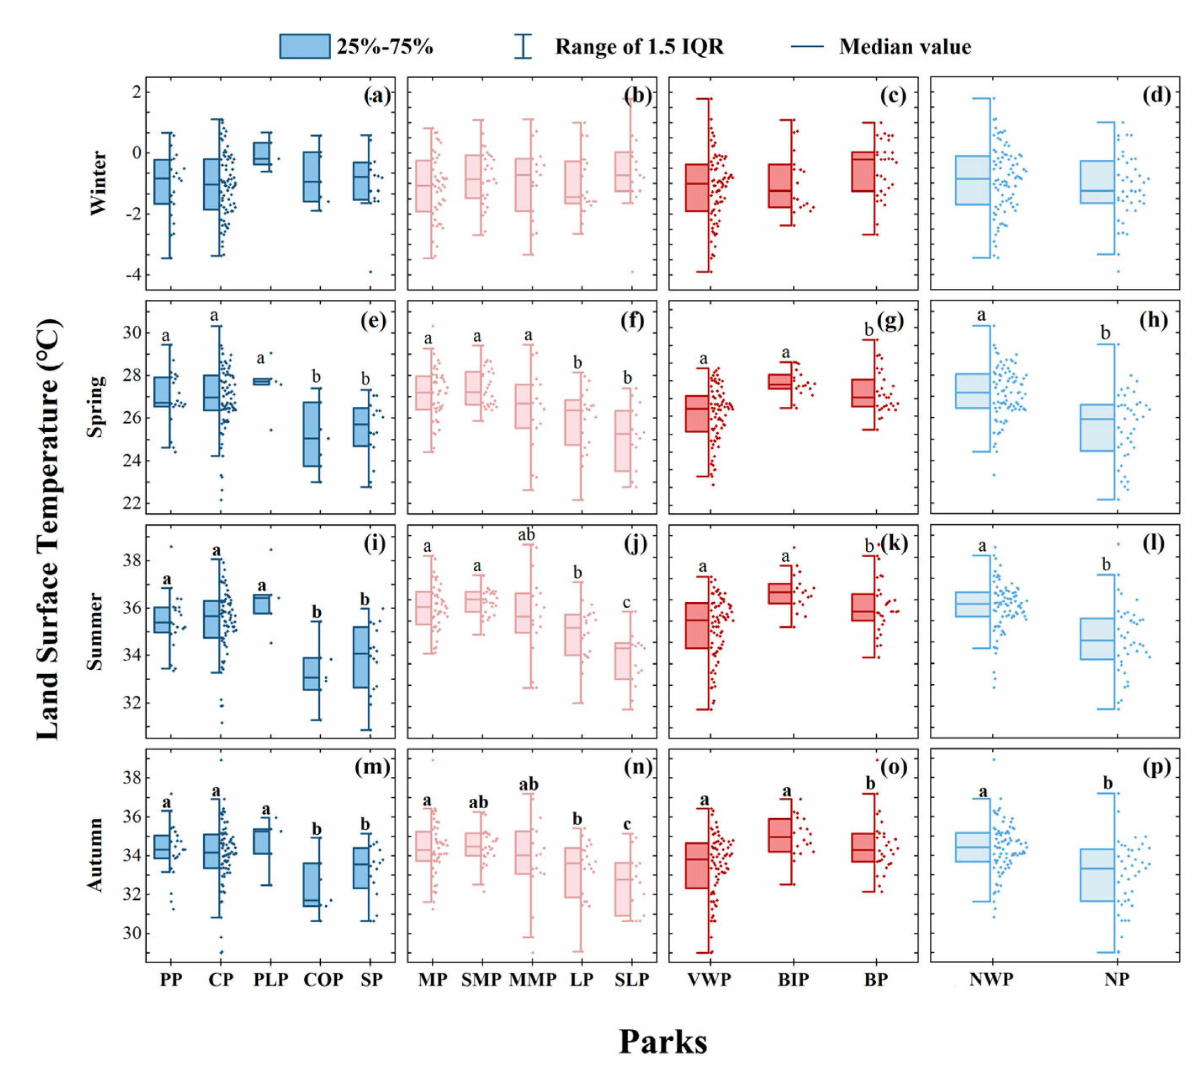
Figure 6. Park category differences of LST in different seasons ( a – p ). a, b, c, represent significant differences determined by Fisher’s least significant difference (LSD) tests ( p < 0.05) on different seasons for different park